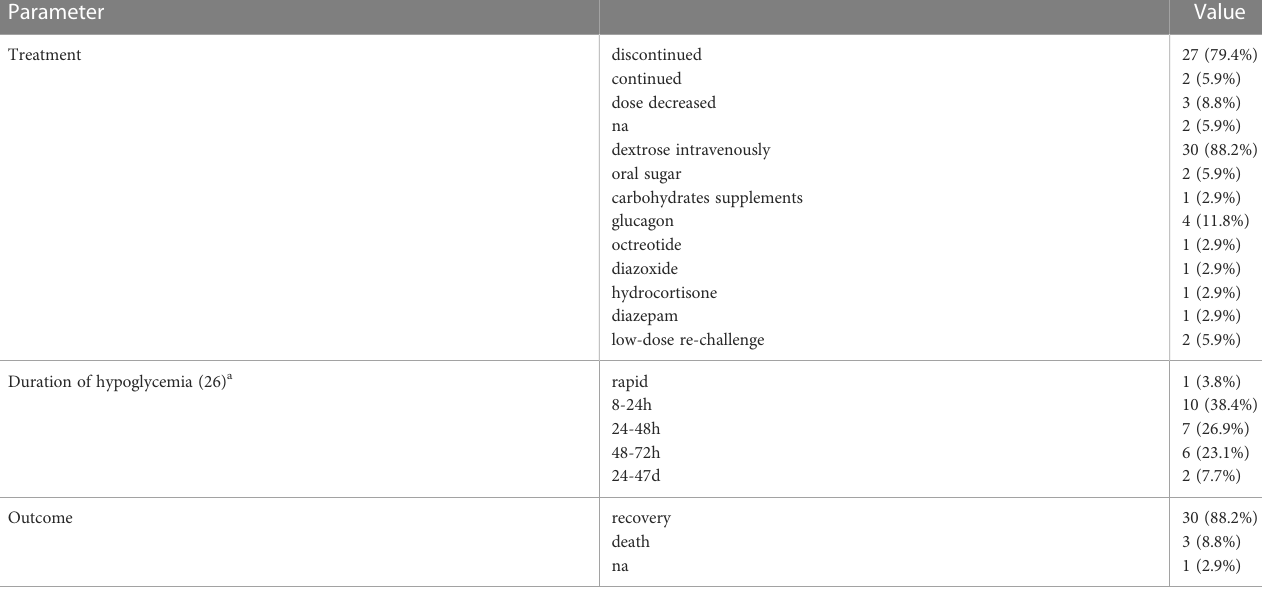
TABLE 4 Summary of treatment and prognosis of 34 patients.